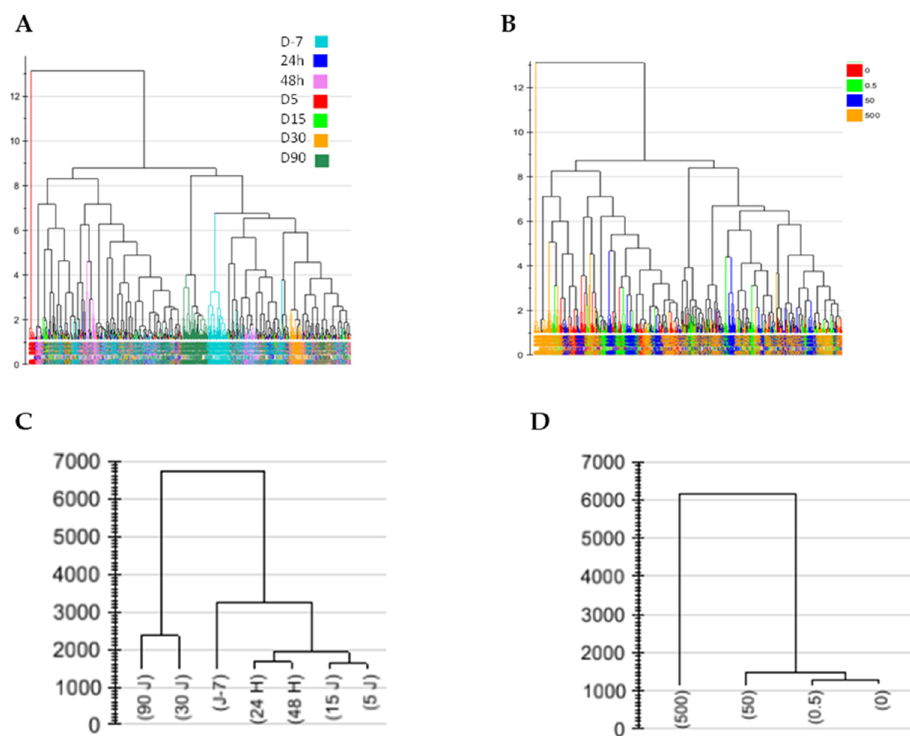
Figure 2. Hierarchical clustering of observations based on the 30 principal component analyses ( A , B ) or 10 ( C ) or 20 ( D ) PLS-DA components performed on all urine sampling times and NU doses. Each component influence is weighted according to its respective eigenvalue. Hierarchical classification analysis with Ward as the clustering method and tree sorted by size. In ( A ), sample colors correspond to sampling times; in ( B ), sample colors refer to NU doses. ( C , D ) represent the c(corr) vector, showing how well the X variables (mass features intensity) fit with the Y variables (either time factor in ( C ) or the dose factor in ( D )). This vector can be seen as the barycenter of each time group or NU dose group. In ( C ), the time response was highly significant in PLS-DA analysis (P after cross-validation ANOVA = 0), whereas in ( D ), the dose response was not (P after cross-validation ANOVA = 1).